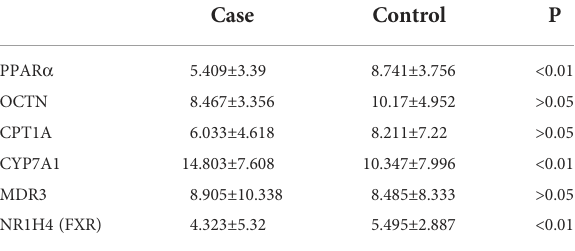
TABLE 4 Semi-quantitative ImageJ analysis of pathological